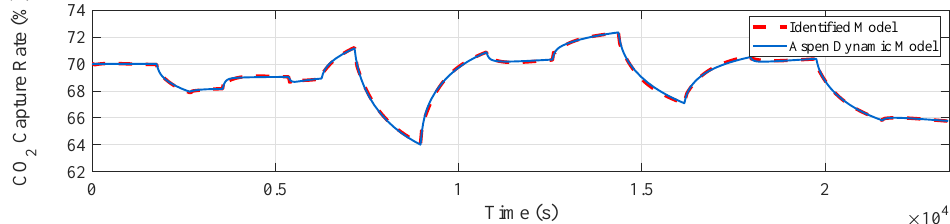
Figure 8. Measured and simulated model outputs of the CO 2 capture system.